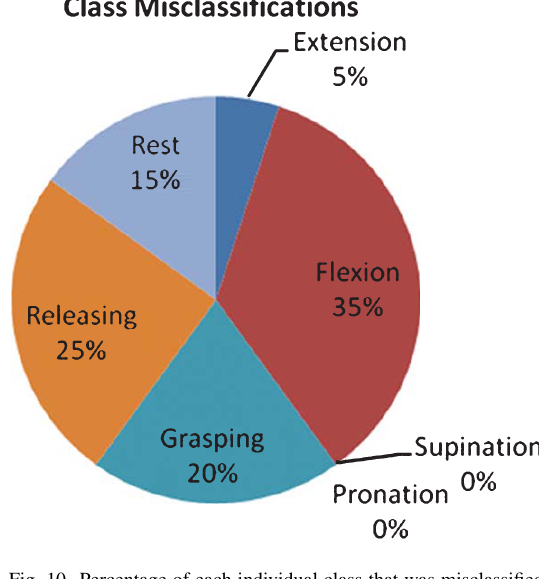
Fig. 10. Percentage of each individual class that was misclassified out of the total number of misclassifications for the CCS subject. Table 2 The overall error for each TDNN neural network with 10 neurons in the hidden layer while varying time delay and time interval for Subject